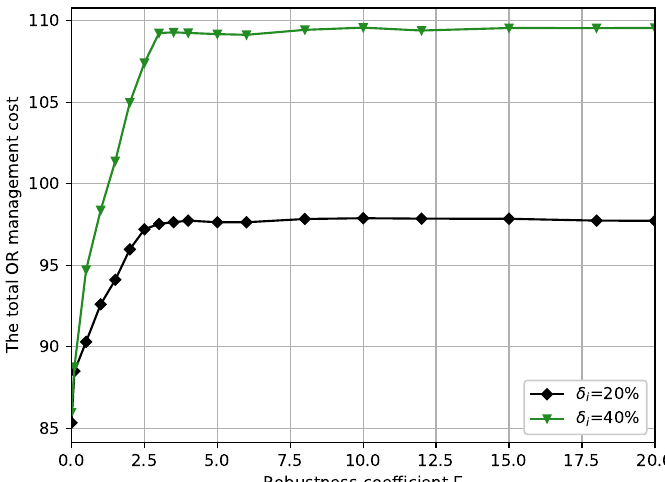
Figure 4. The minimum total OR management cost versus robustness coefficient Γ with different perturbation factors δ i